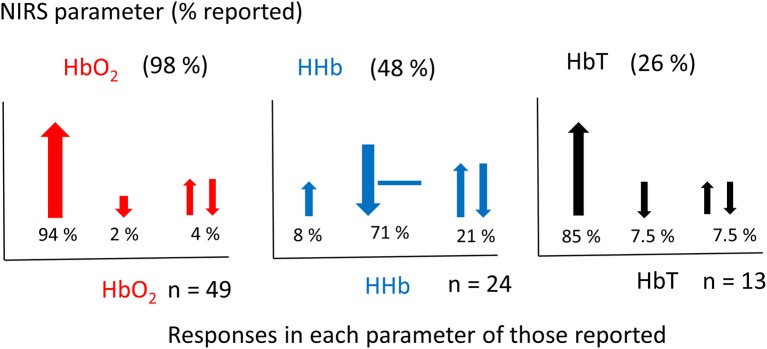
Graphs showing the percentage of NIRS parameters reported in fNIRS studies on newborns (above) (a total set of 51 responses from 46 studies were identified) and the corresponding responses of those reported (below). Changes in [HbO2] shown in red, [HHb] shown in blue and [HbT] shown in black. The total number of studies (n) reporting each variable is stated next to each graph. Directions of responses are indicated with an arrow or a line if no change; responses with a double arrow indicate a mixed response (both positive and negative changes observed). Size of arrows correspond to occurrence.